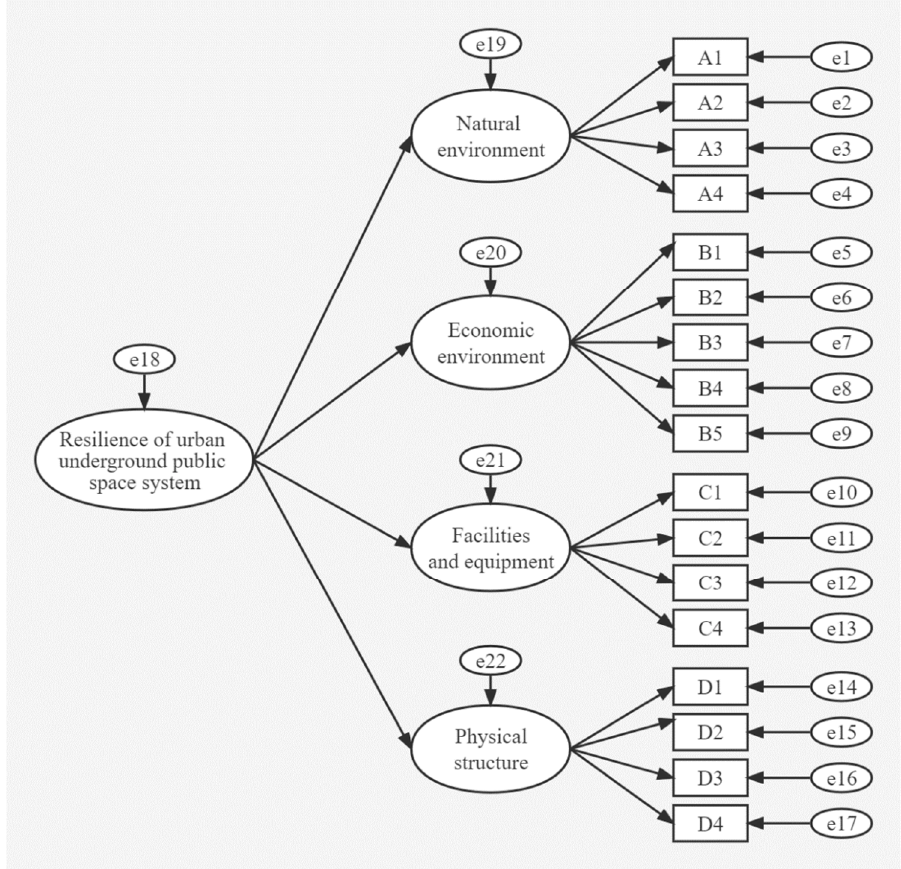
Figure 1. The path diagram of the structural equation model to represent the resilience of the underground public space (UPS) system. Table 2. The four research hypothesis